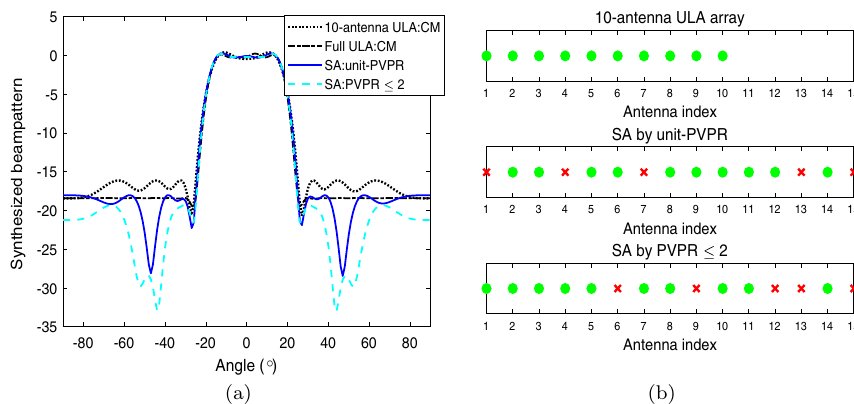
Fig. 9 a Synthesized beampatterns with spectral compatibility; b Antenna locations